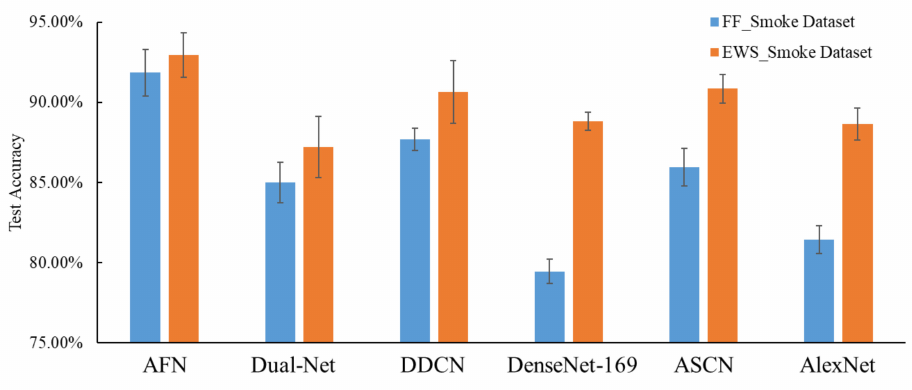
Figure 5. Average test accuracy on self-built smoke datasets. The error line represents the standard